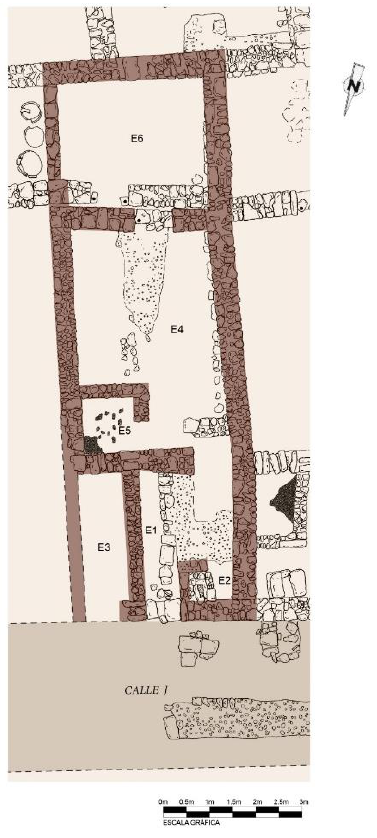
Figure 13. Variant 1. House 101. Plan and room distribution.